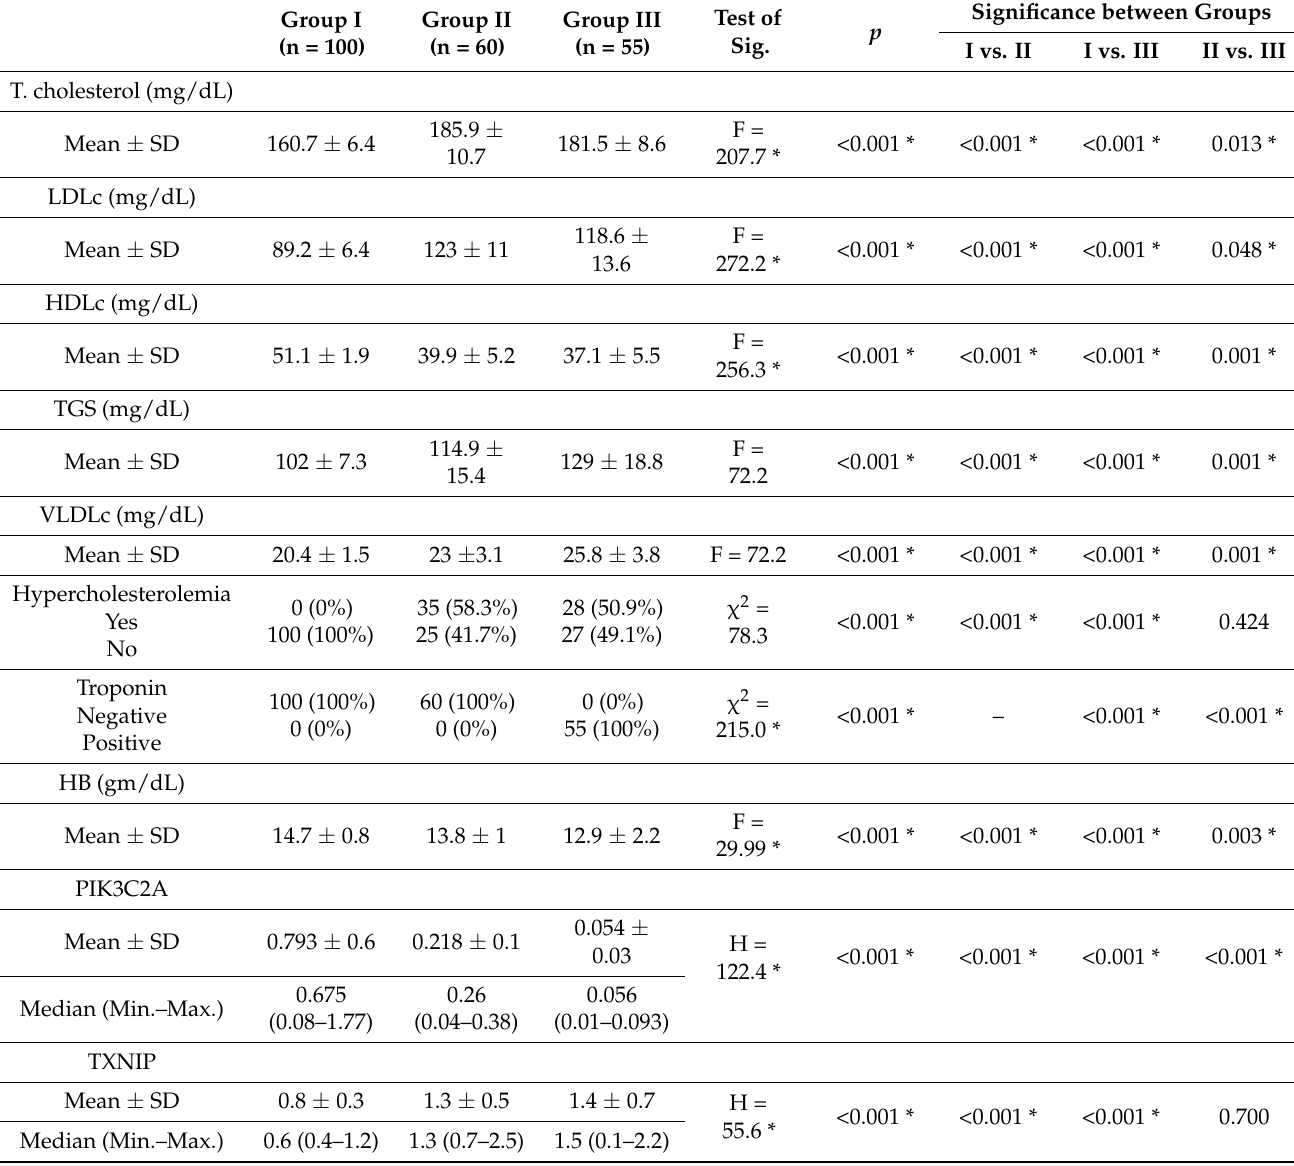
Table 2. Comparison between the studied groups regarding biochemical